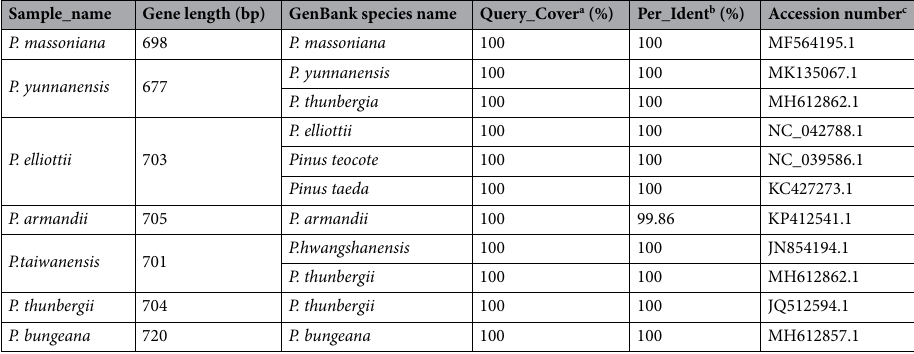
Table 2. rbcL sequence markers results. a Query_cover, the percentage of the sample sequence covered by the GenBank sequence. b Per_Ident, the percentage similarity of the sample and GenBank sequences. c Accession number, the GenBank accession number. d NA, no match for the same species.